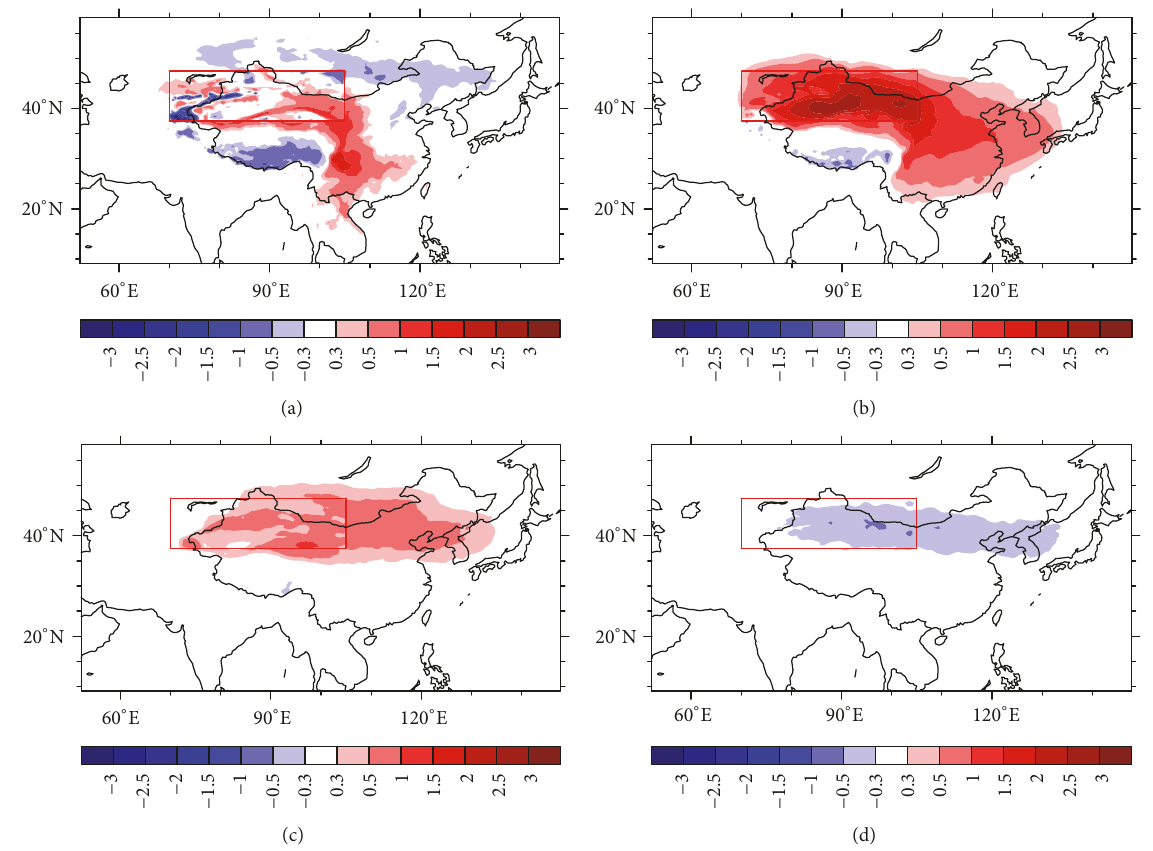
Figure 6: The temperature DIF (SE − CE; K) at the height of (a) 2 m, (b) 700 hPa, (c) 500 hPa, and (d) 200 hPa in April averaged from 2001 to